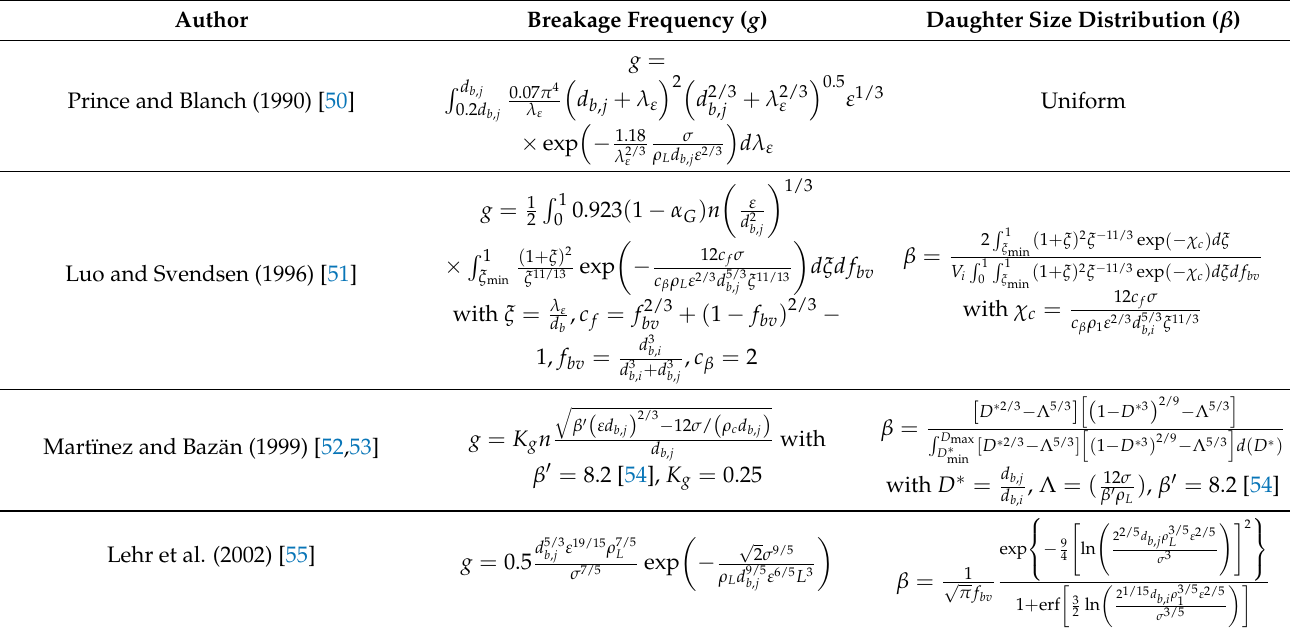
Table 2. Applicable breakup models for simulated bubble